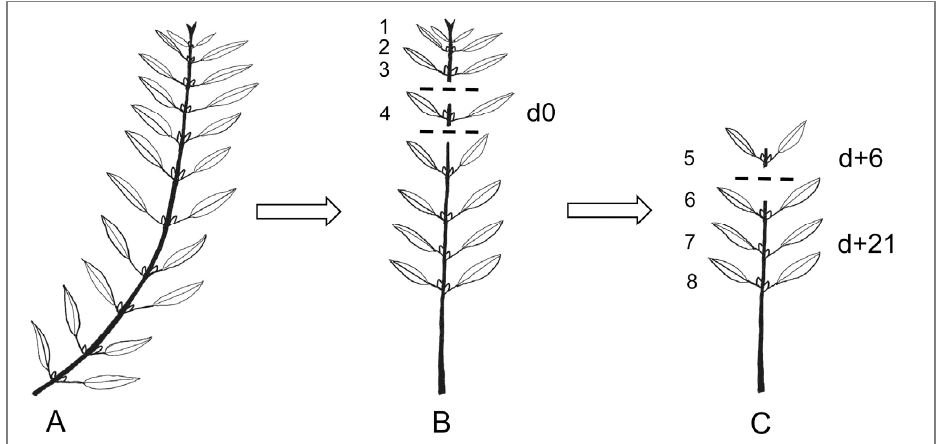
Figure 7. Procedure to obtain cuttings and samples for anatomical observations. ( A ) Shoots with at least 8 nodes are sampled from the tree. ( B ) The 3 distal (tip) nodes and the leaves and buds below node 8 are removed. Node 4 is fixed on the initial date (d0) for later microscopic observation, and cuttings containing nodes 5–8 are forced under controlled conditions. ( C ) After 6 days (d + 6) forcing, node 5 is fixed. The cuttings, now containing 3 nodes, are maintained under forcing until a total of 21 days (d + 21).